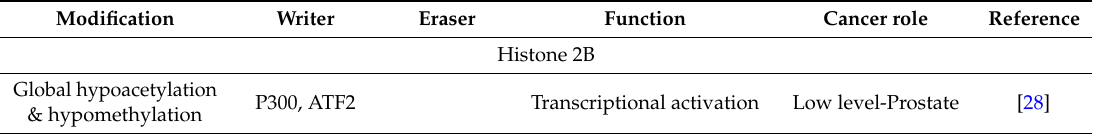
Table 1. Histone 2B: post-translational modifications (PTM) quantification as cancer